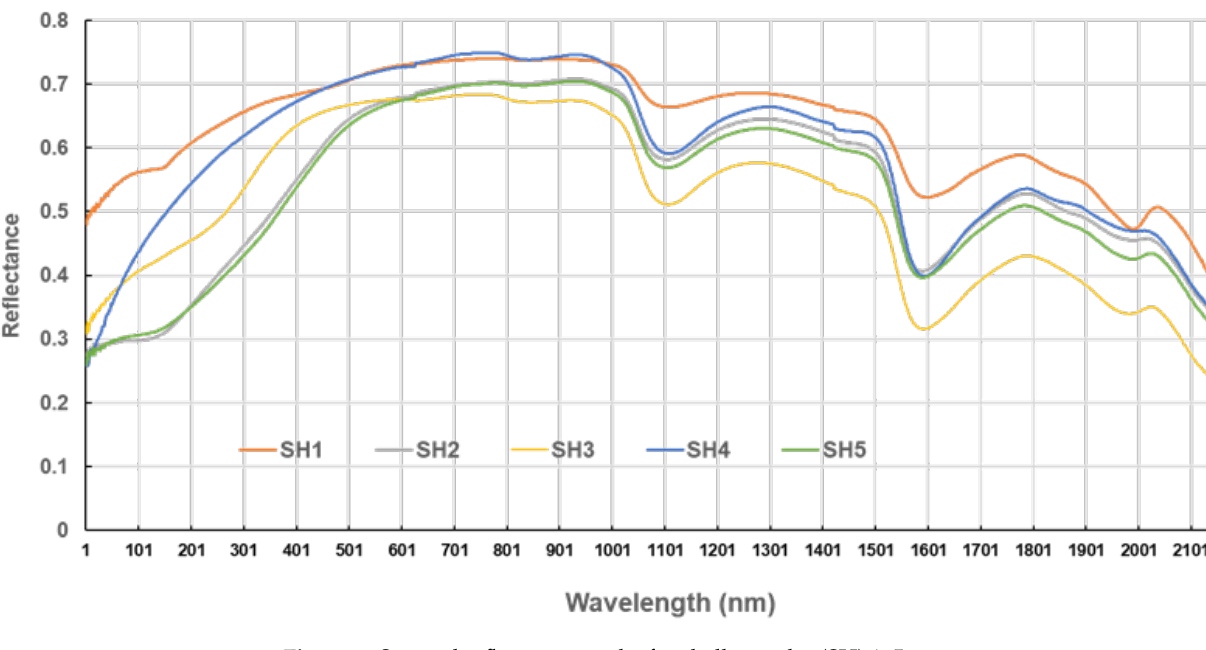
Figure 9. Spectral reflectance results for shell samples (SH) 1 – 5.